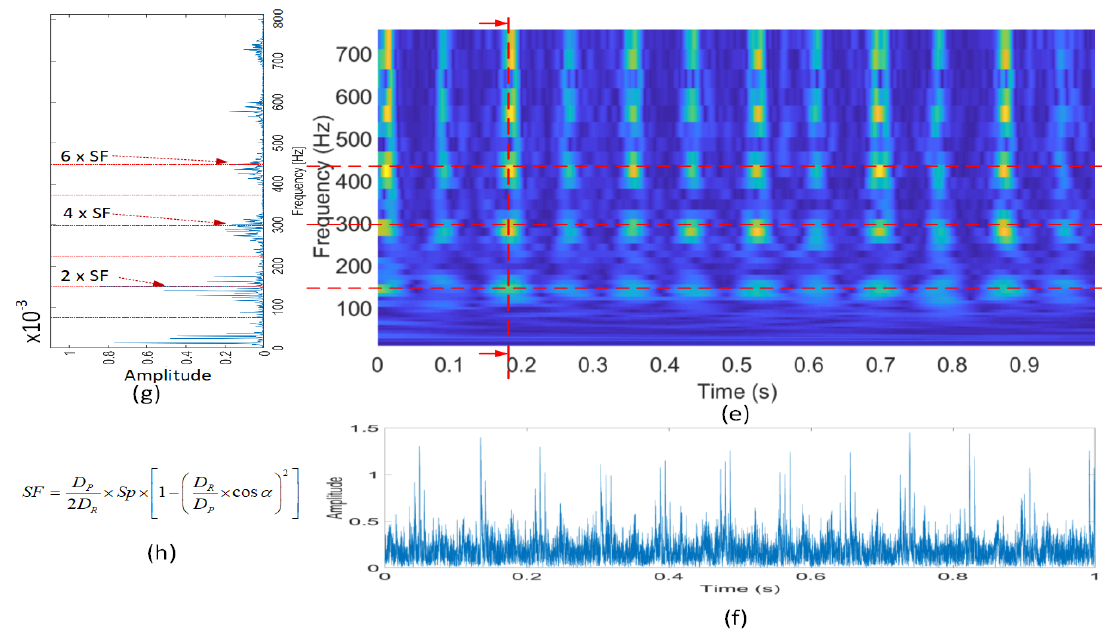
Figure 3. cont Figure 3. 2-D representation of the signals corresponding to the inner and roller faults: ( a ) DSWI for inner fault, ( b ) envelope signal for inner fault, ( c ) envelope spectrum with FI defect frequency for inner fault, ( d ) inner defect frequency FI, ( e ) DSWI for roller fault, ( f ) envelope signal for roller fault, ( g ) envelope spectrum with SF defect frequency for roller fault, and ( h ) roller (ball spin) defect frequency SF,